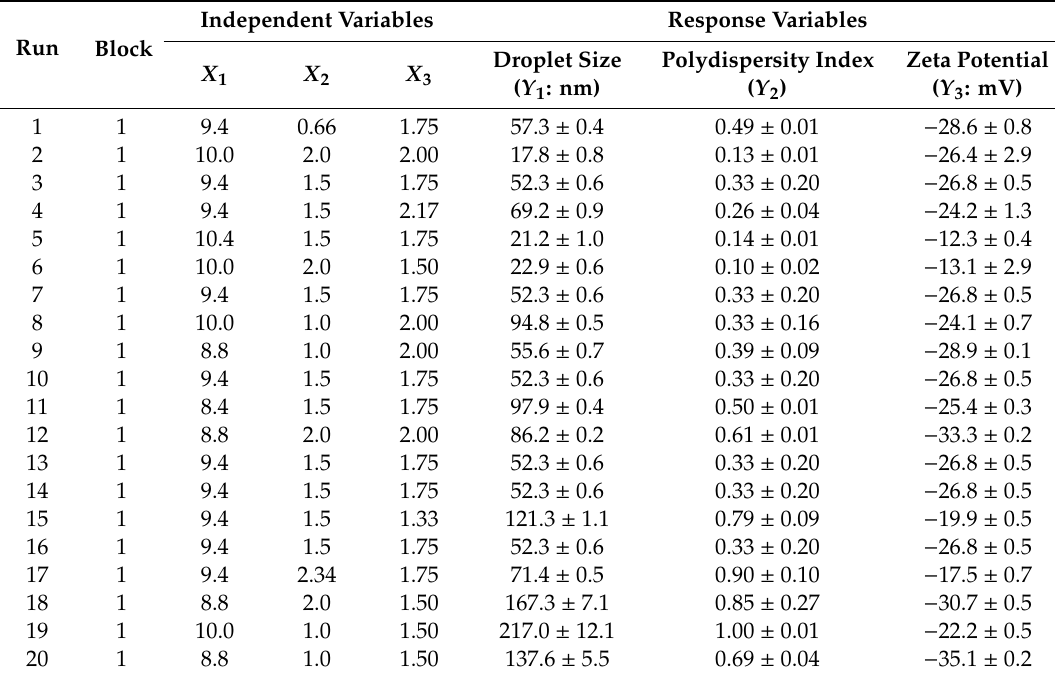
Table 2. The matrix of central composite design (CCD) and the experimental data obtained for the response variables studied; Y 1 : droplet size, Y 2 : polydispersity index (PDI), and Y 3 : zeta potential (mean ± SD).